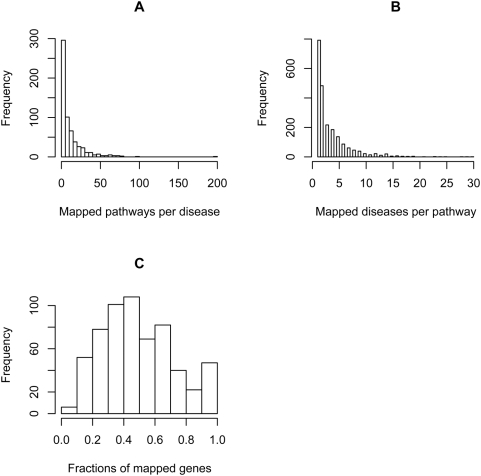
Disease pathway mapping.A) Distribution of the number of mapped pathways per disease. B) Distribution of the number of mapped diseases per pathway. C) Distribution of the fraction of disease associated genes mapped to pathways.